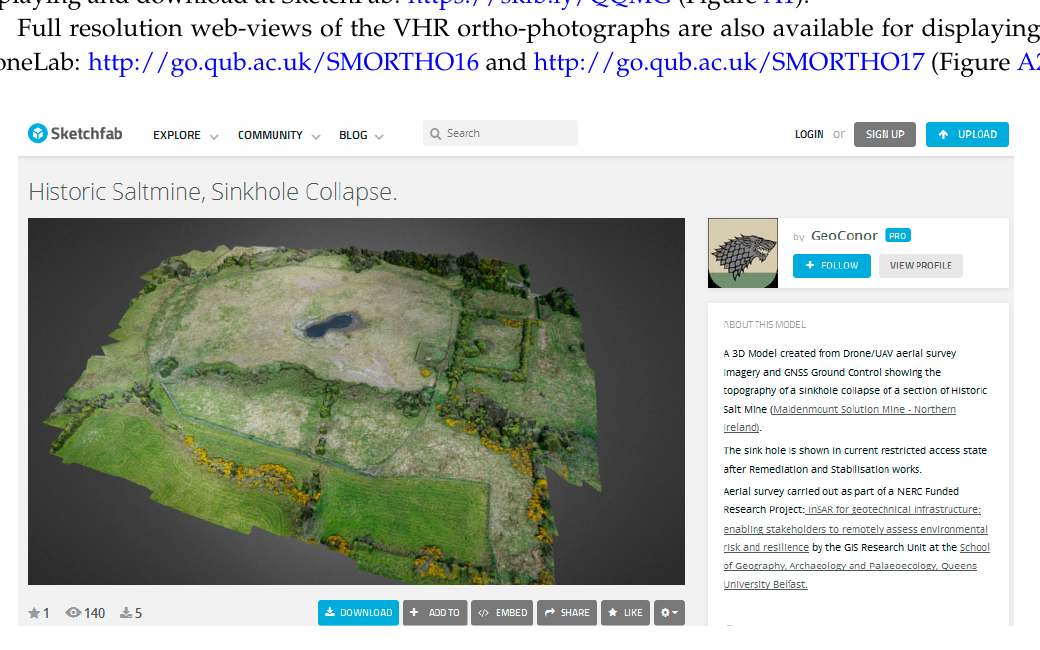
Figure A1 . SUAV-derived DSM of the Maiden Mount salt mine collapse at Carrickfergus, UK, available for 3D displaying and download via SketchFab.